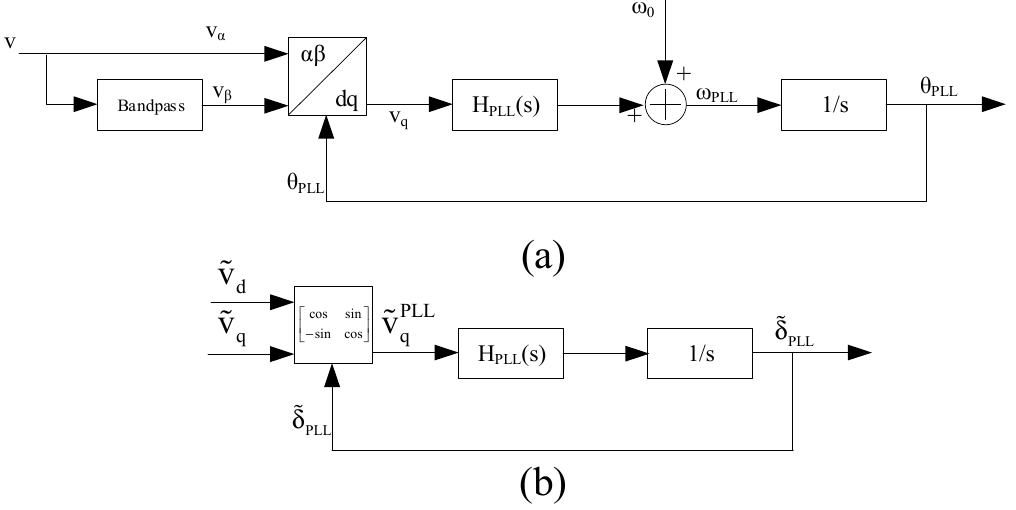
Figure 7. The block diagram of a typical SRF (synchronous rotation frame) PLL. ( a ) Block diagram of a typical single-phase SRF PLL; ( b ) Small signal model of SRF PLL.